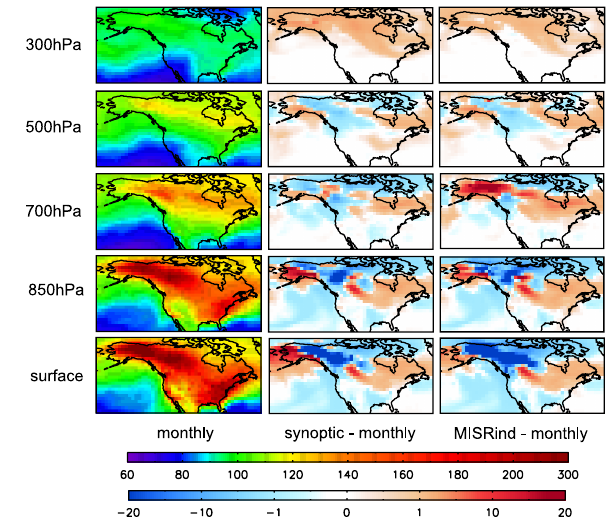
Fig. 4. Model simulated 3-month (June–August 2004) average CO mixing ratios (ppbv) at five pressure layers (surface, 850hPa, 700hPa, 500hPa, 300hPa) from the monthly simulation, and the differences due to the adding of temporal constraints ( synoptic – monthly ), and due to the adding of both temporal constraints and MISRind injection height of biomass burning emissions ( MISRind – monthly